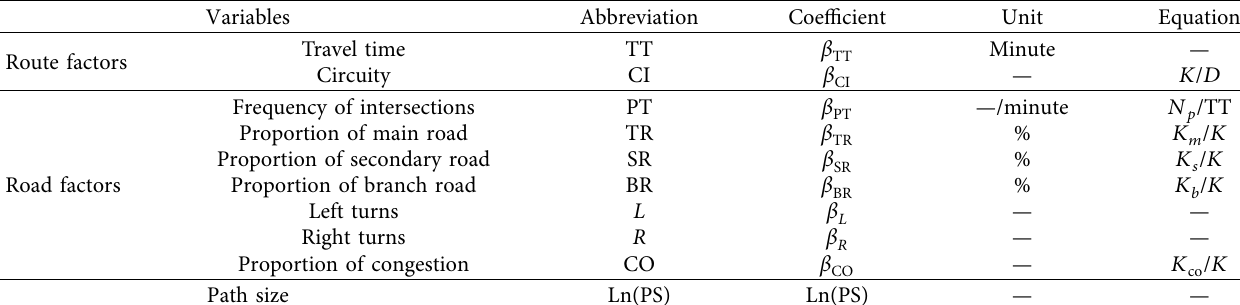
Table 4: Explanatory variables of taxi passenger-carrying route choice